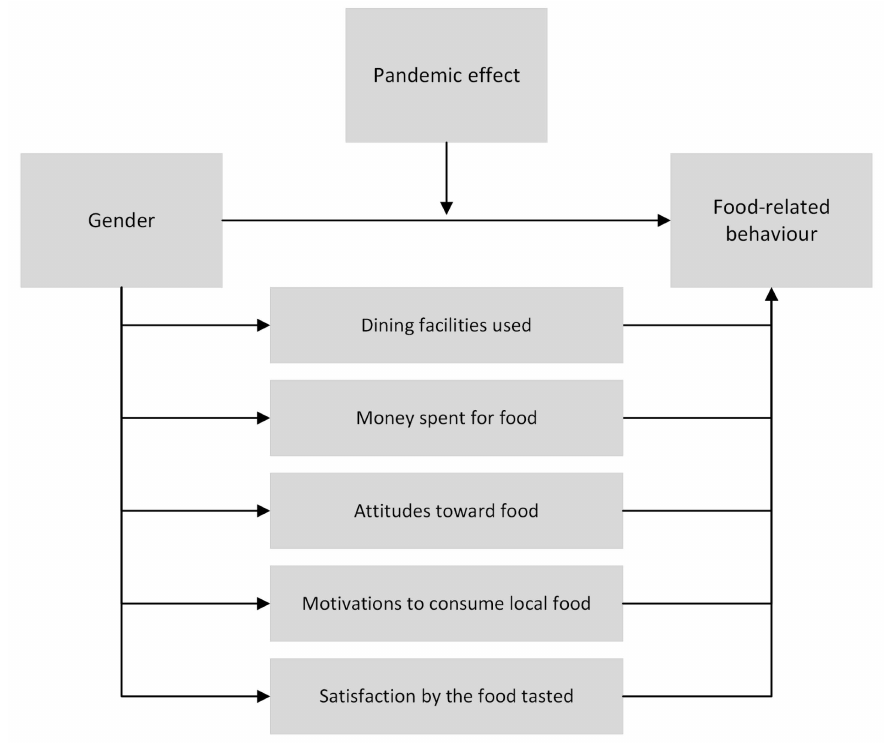
Figure 1. Conceptual framework of the study